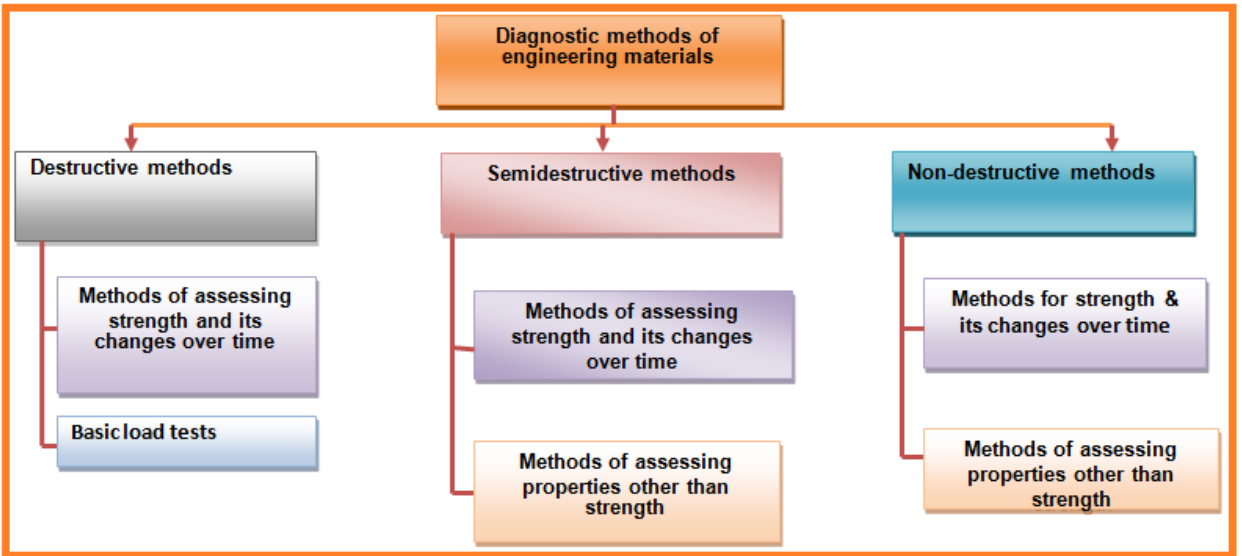
Figure 3. The basic classification of diagnostic methods for engineering materials.